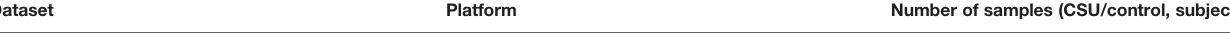
TABLE 1 | Details of the GEO CSU data. Dataset